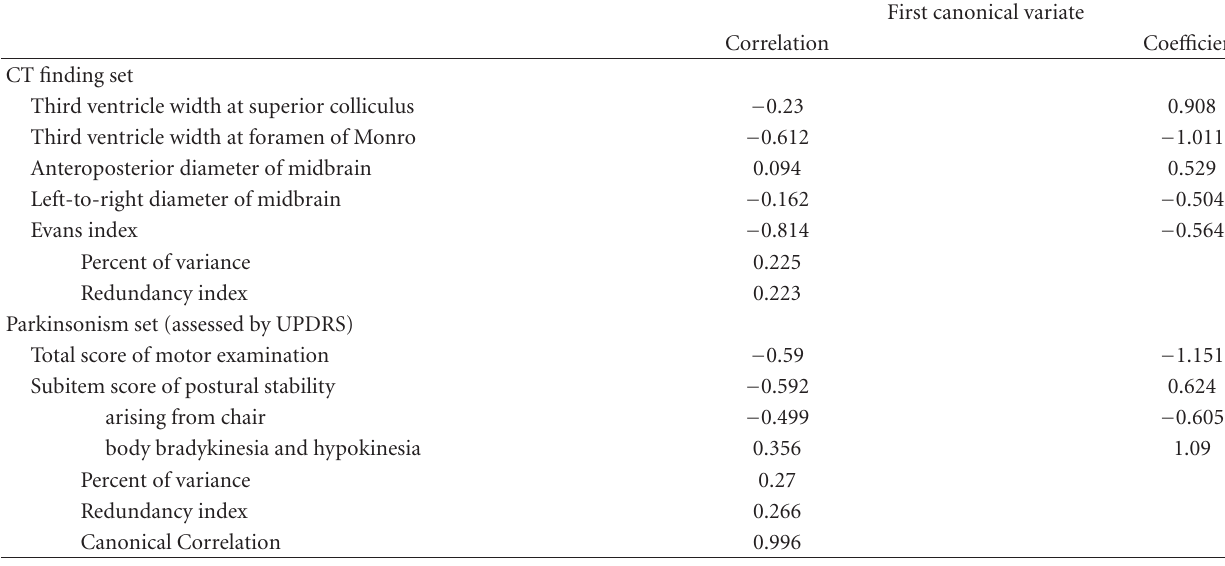
Table 4: Canonical correlations between the grades of the Parkinsonian features responding to the ventriculoperitoneal shunt operation and computed tomography